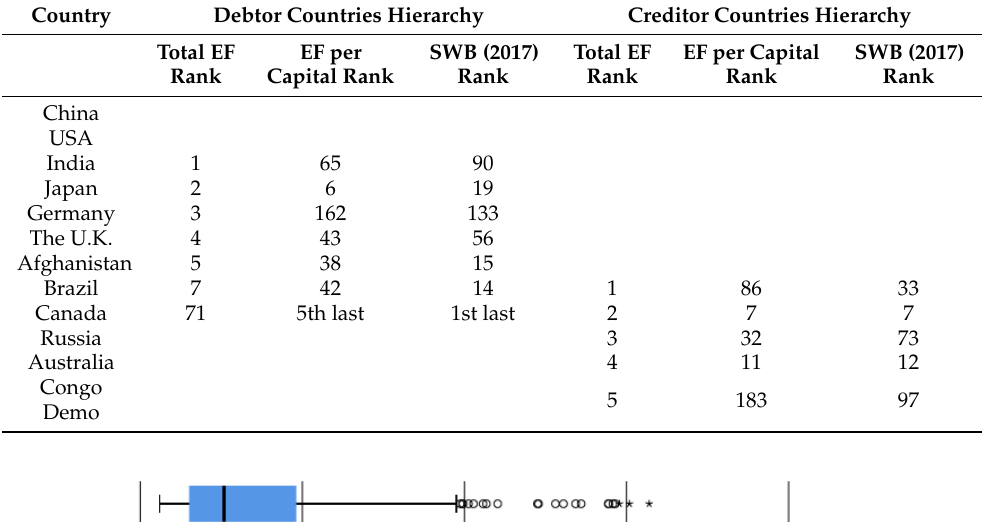
Table 5. The ranking between TEF and EF per capital.